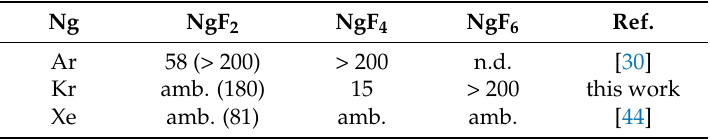
Table 2. Comparison of the theoretical thermodynamic stability NgF 2 , NgF 4 , and NgF 6 (Ng = Ar, Kr, Xe) compounds up to pressures of 200 GPa. Pressures at which a given stoichiometry is stable are given in GPa (amb.—stable at ambient pressure; n.d.—not determined). For NgF 2 the numbers in parenthesis correspond to the decomposition pressure given in GPa. Ng NgF 2 NgF 4 NgF 6 Ref. Ar 58 (> 200) > 200 n.d. [30] Kr amb. (180) 15 > 200 this work Xe amb. (81) amb. amb.